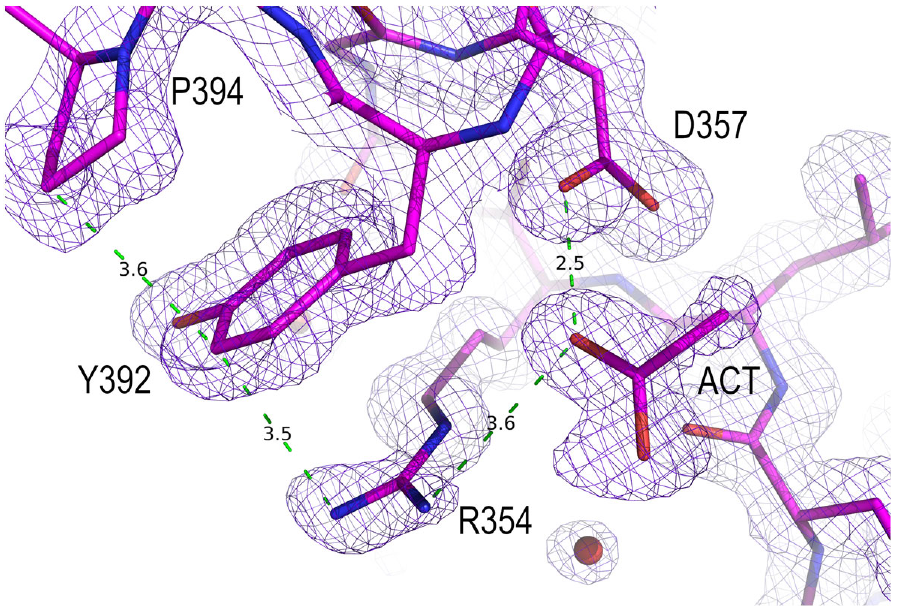
Figure 5. Interaction of the acetate ion and Asp357 in the trigonal polymorph. Difference electron density map 2Fo ‐ Fc is countered to 1 σ .